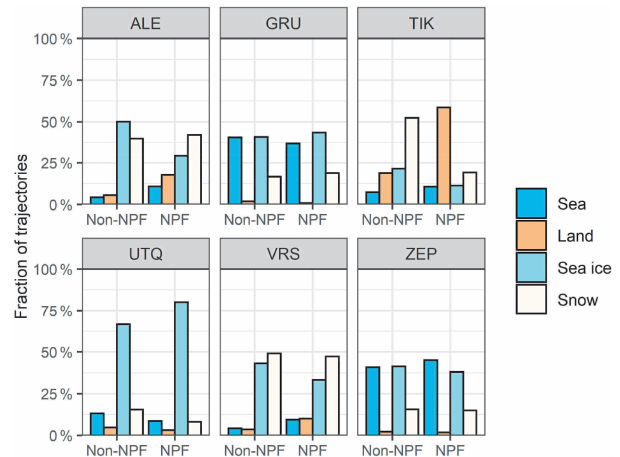
Figure 5. Link between surface type and 72h HYSPLIT back tra- jectory points during NPF events and outside of NPF events. Air masses were assigned a surface type based upon a 24km grid of IMS